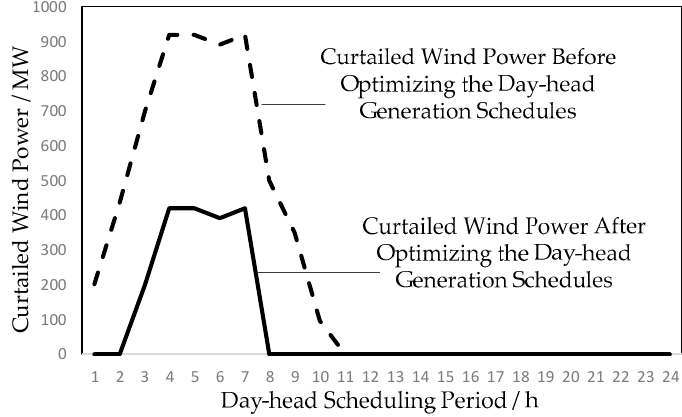
Figure 9. Comparation of curtailed wind power before and after optimizing the day-head generation schedules.